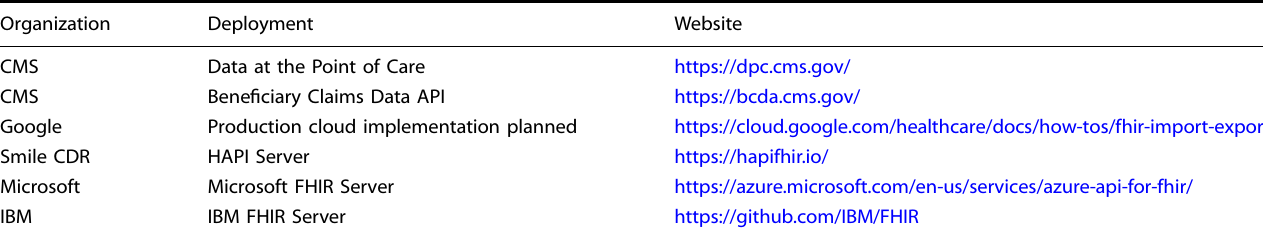
Table 2. Examples of existing SMART/HL7 Bulk FHIR export